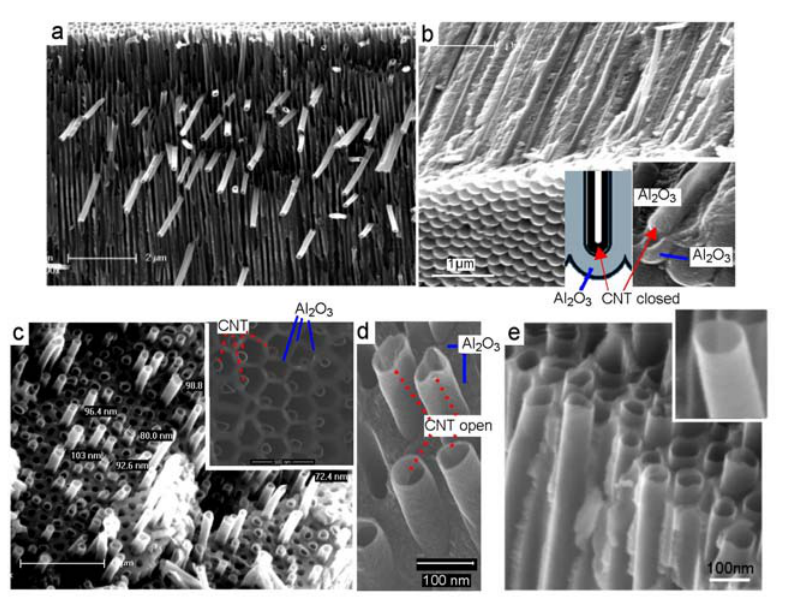
Figure 3. SEM images of carbon nanotube (CNT) synthetised inside of pores of PA membrane. (a) cross-sectional image of prepared CNT/PA composite membrane showing CNT inside of pores; (b) a cross-sectional image from the bottom in case when PA bottom was closed. Inset shows scheme of closed pores; (c) CNT structure inside of pores obtained from fractured membranes. Inset show CNT after partial removal of oxide; (d-e) high resolution images of CNT inside of pore showing that CNTs have identical shape as pore